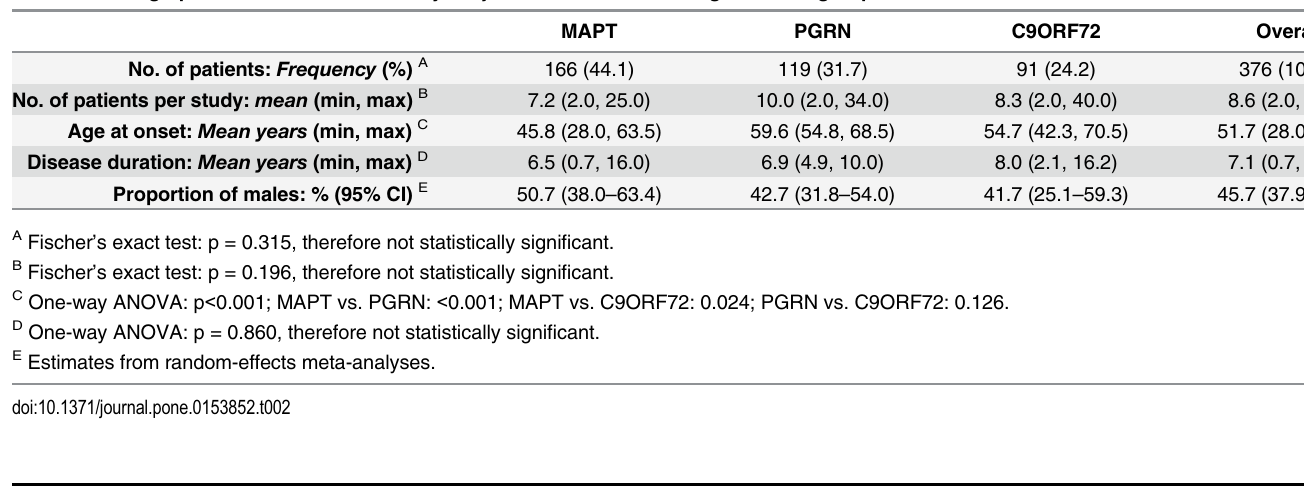
Table 2. Demographic characteristics of study subjects stratified based on genetic